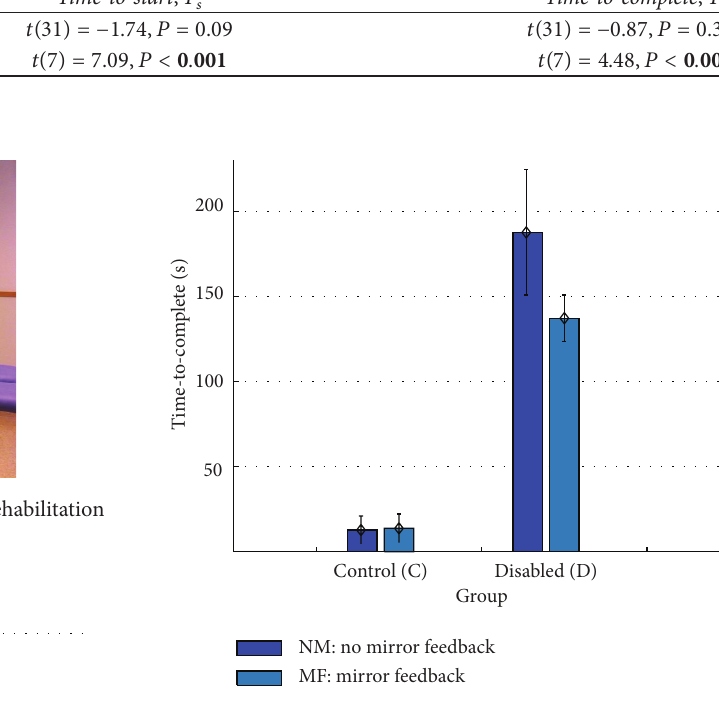
Figure 7: Overview of mean times for the time-to-complete measure ( 𝑇 𝑐